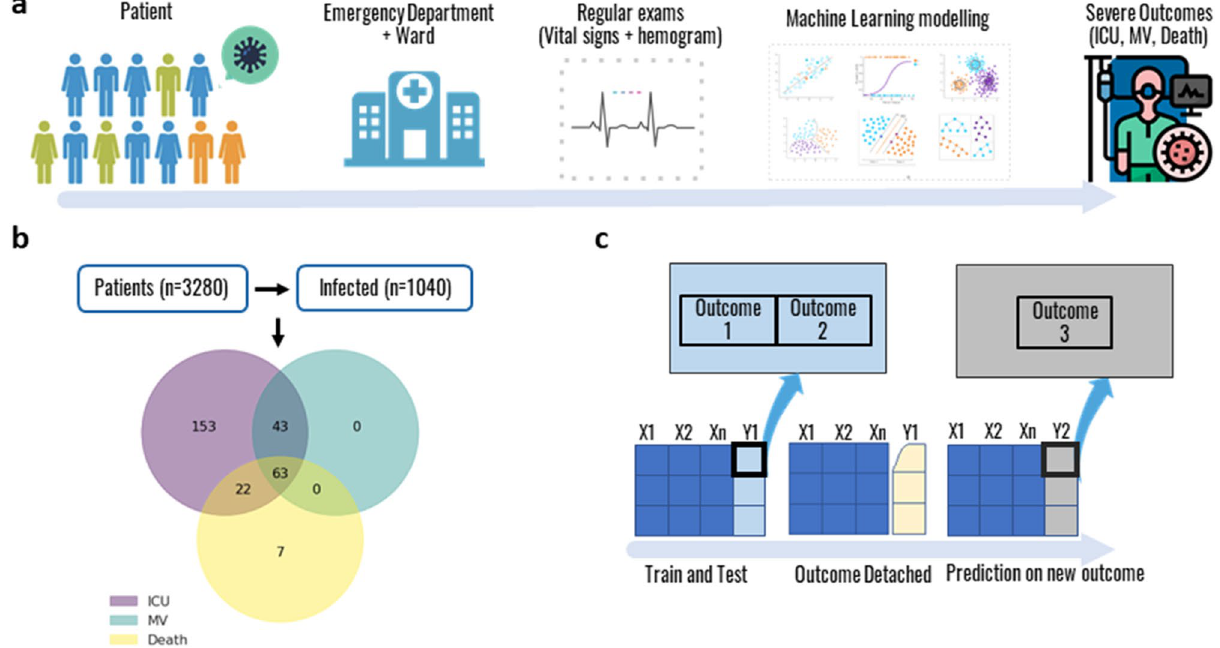
Figure 3. Overview of the study process. ( a ) From hospital admission to the final outcome. ( b ) Population inclusion criteria and outcomes intersection. ( c ) The algorithm was trained and tested using a combination of two outcomes. The same algorithm was then used to predict the remaining